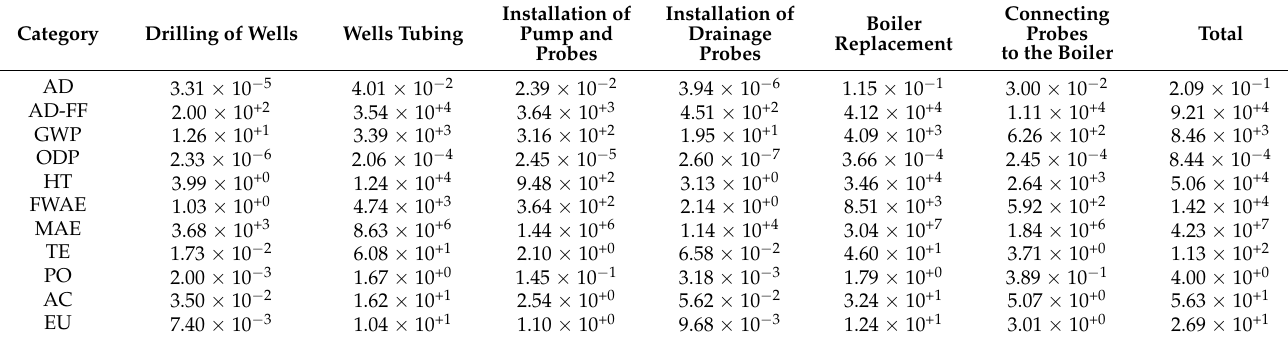
Table 6. Environmental impact by phases for alternative